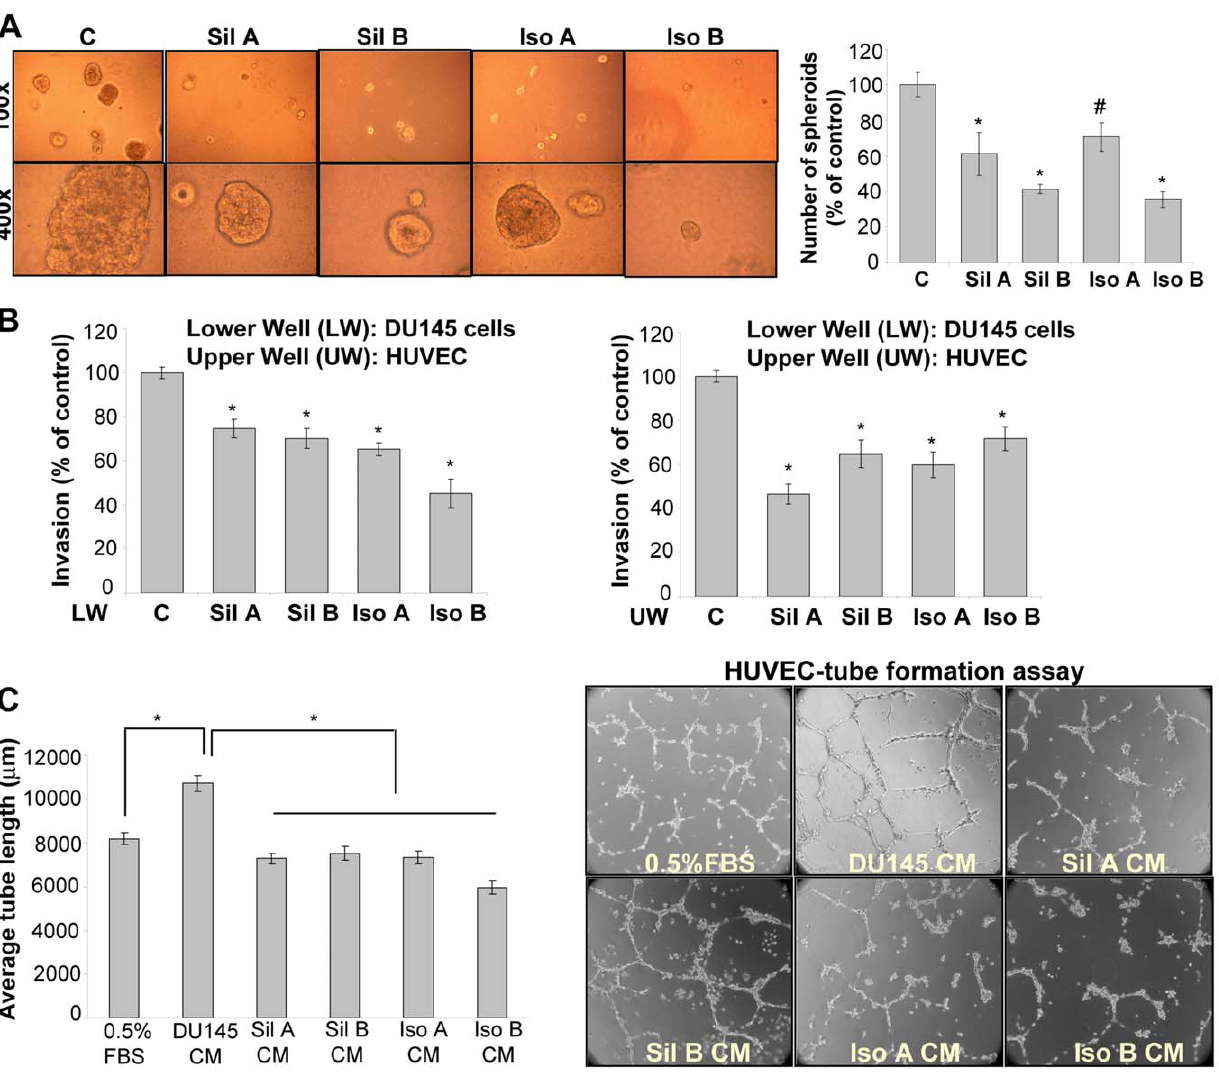
Figure 9. Differential effect of flavonolignans on human PCA DU145 cells and endothelial HUVEC in cell culture assays. ( A ) Effect of flavonolignans (at 90 m M dose) on the three dimensional growth of DU145 cells was studied as detailed in ‘Materials and Methods’. Representative spheroids photomicrographs are shown at 100x and 400x. ( B ) In Transwell invasion assay, either DU145 cells (plated in the lower chamber) or HUVEC (plated in the upper chamber) were treated with individual diastereoisomers (at 30 m M dose), and HUVEC invasiveness was measured. ( C ) DU145 cells were treated with individual diastereoisomers (at 30 m M dose) and conditioned media was collected. HUVEC were plated on matrigel along with 0.5% FBS or conditioned media from different treatment groups; and tube formation was analyzed. Representative photomicrographs of tubular network are shown at 100x. Abbreviations: Sil A: Silybin A; Sil B: Silybin B; Iso A: Isosilybin A, Iso B: Isosilybin B; CM: Conditioned media; *, p # 0.001; # , p #